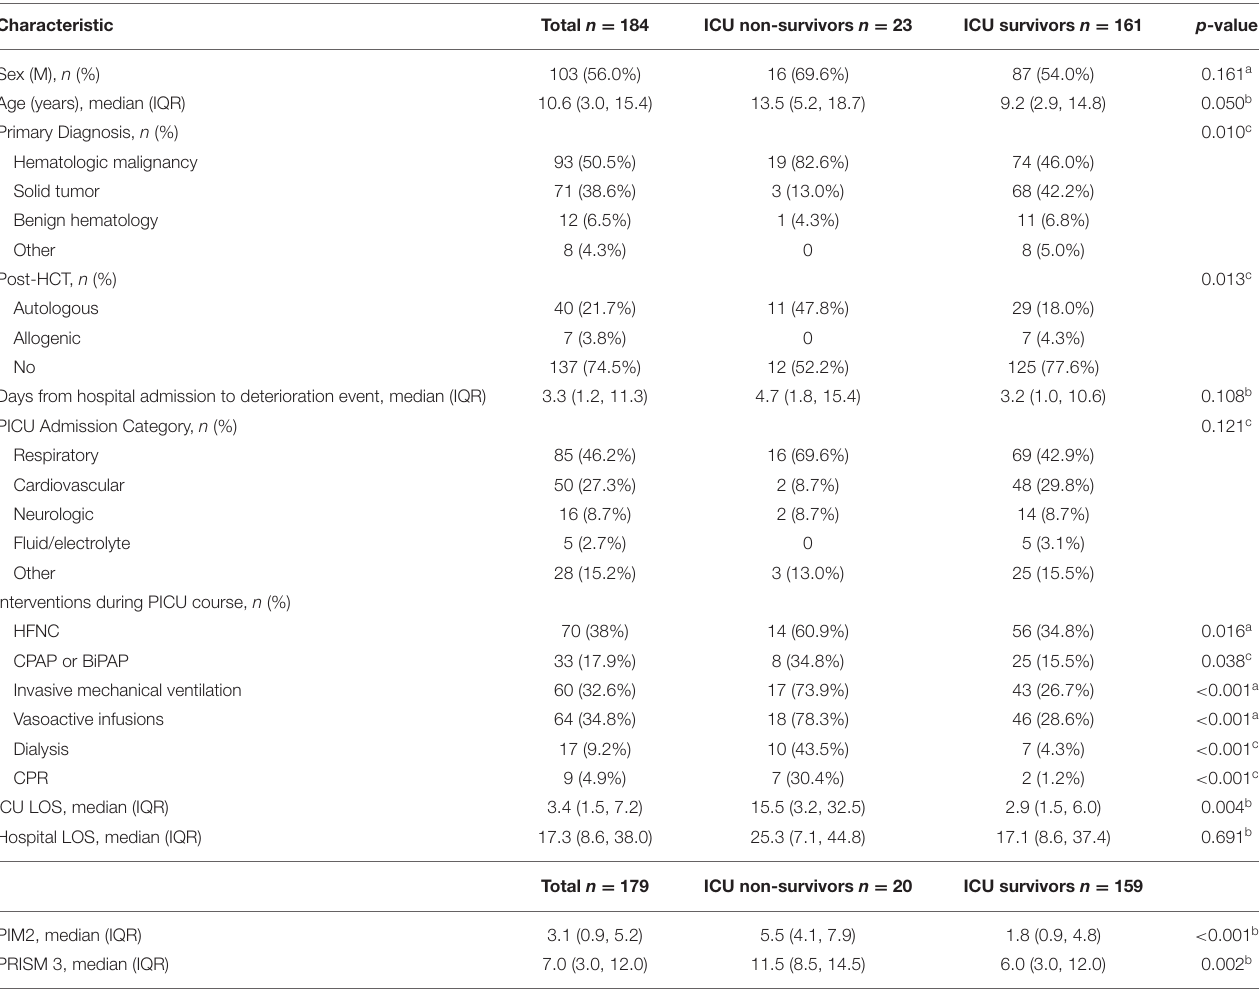
TABLE 1 | PICU mortality in hospitalized pediatric hematology-oncology patients with deterioration. Characteristic Total n =